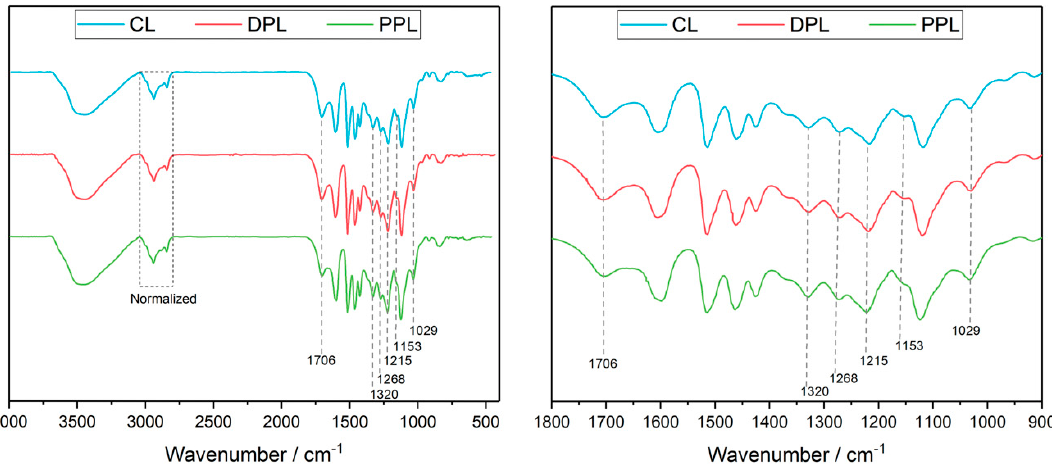
Figure 3. Fourier transform infrared spectroscopy (FTIR) spectra of CL, DPL and PPL.